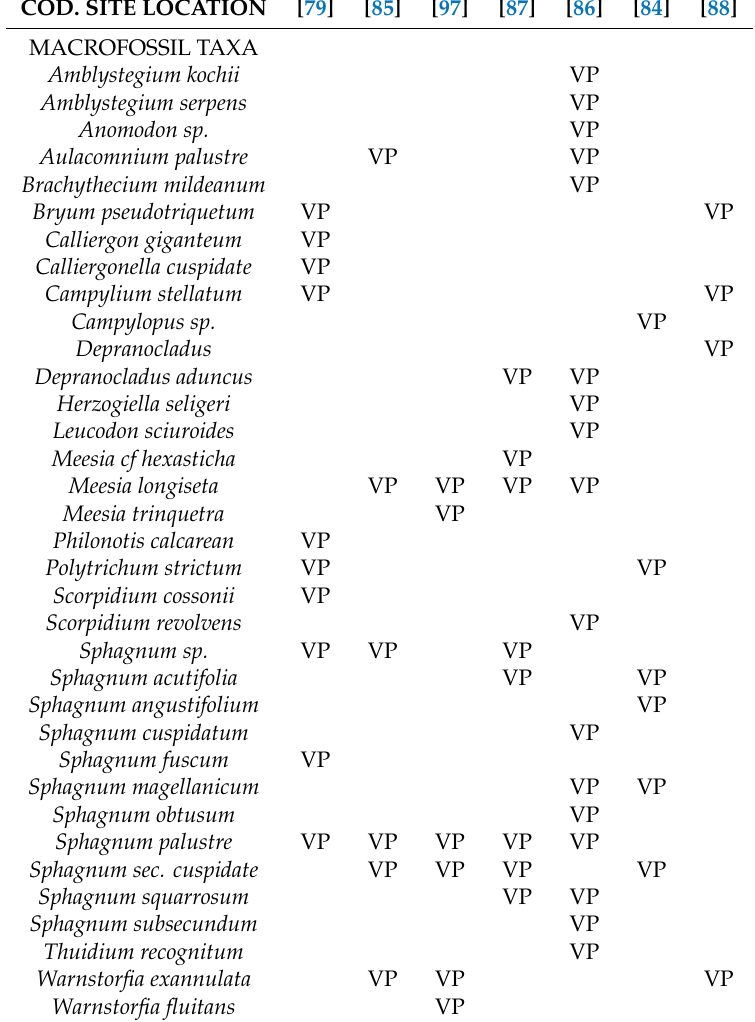
Table 4. Bryophyta macrofossil. Abbreviations: VP—Vegetative parts. Ref.: The references correspond to the numbering in the